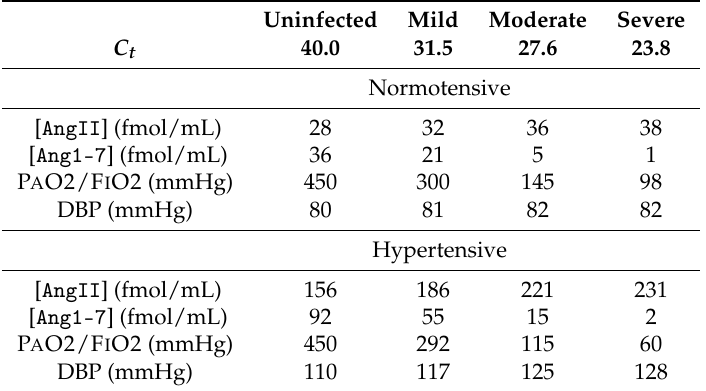
Table 4. Prediction of biochemical and clinical features of SARS-CoV-2